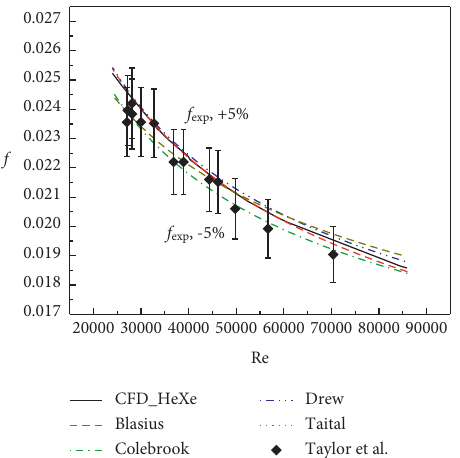
Figure 11: Comparison of calculated wall friction factor with experimental data of helium-xenon mixtures.